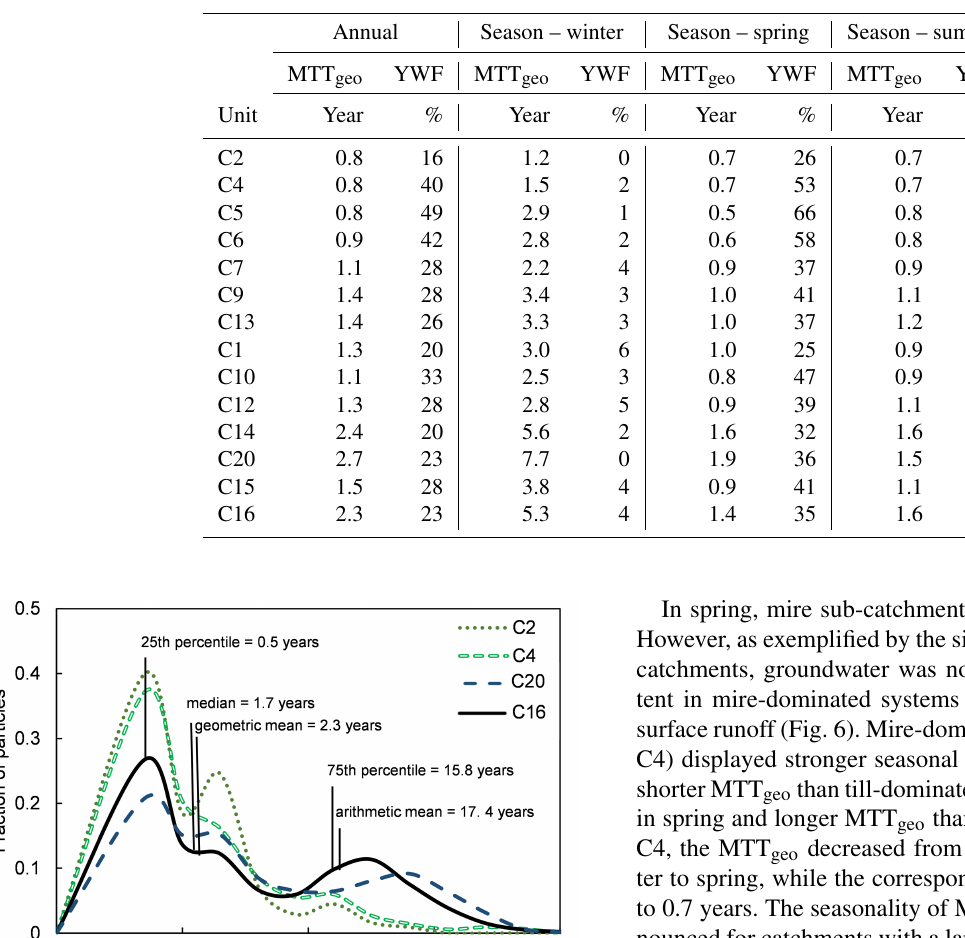
Table 5. Annual and seasonal (winter, spring, and summer) travel times . The geometric mean of the travel time distribution (MTT geo ) is adjusted for the overland flow. The young water fraction (YWF) includes overland flow and groundwater younger than 3 months (%). An extended version of the results, including arithmetic mean, median, and SD, is included in the Appendix (Table A2).